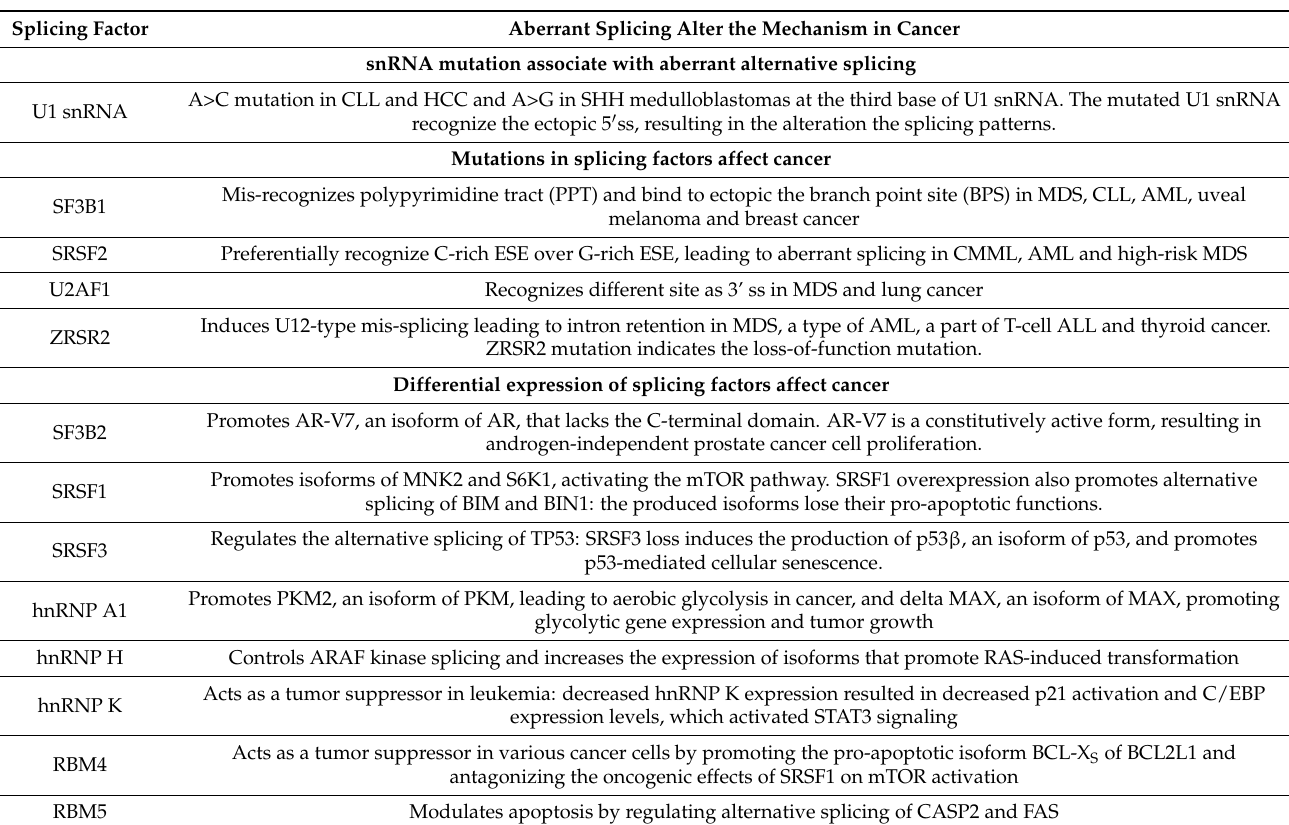
Table 1. Aberrant splicing depending on mutations or different expression of splicing factors in cancer. Splicing